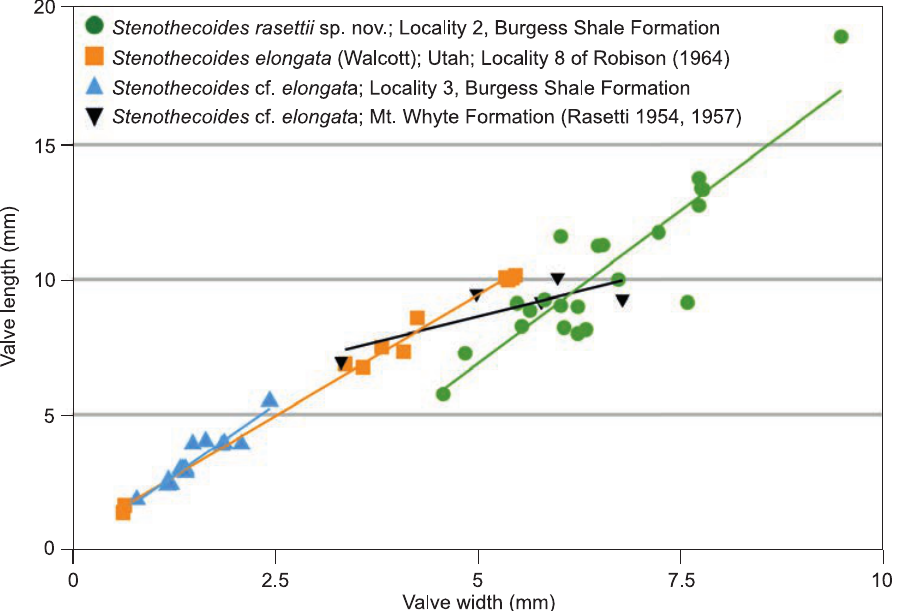
Fig. 9. Bivariate plots of length and width and best fit lines of Stenothecoides rasettii sp. nov., Burgess Shale Formation, Locality 2 (tectonic strain is evi- dent in some specimens at Locality 1, which are excluded from this plot); Stenothecoides elongata (Walcott, 1884), Wheeler Formation, Drum Mountains, Utah, USA, Locality 8 of Robison (1964); Stenothecoides cf. elongata , Burgess Shale Formation, Locality 3; Stenothecoides cf. elongata , Mount Whyte Formation, Ross Lake, Mount Stephen, and Mount Field, Yoho National Park, Canada (Rasetti 1954,